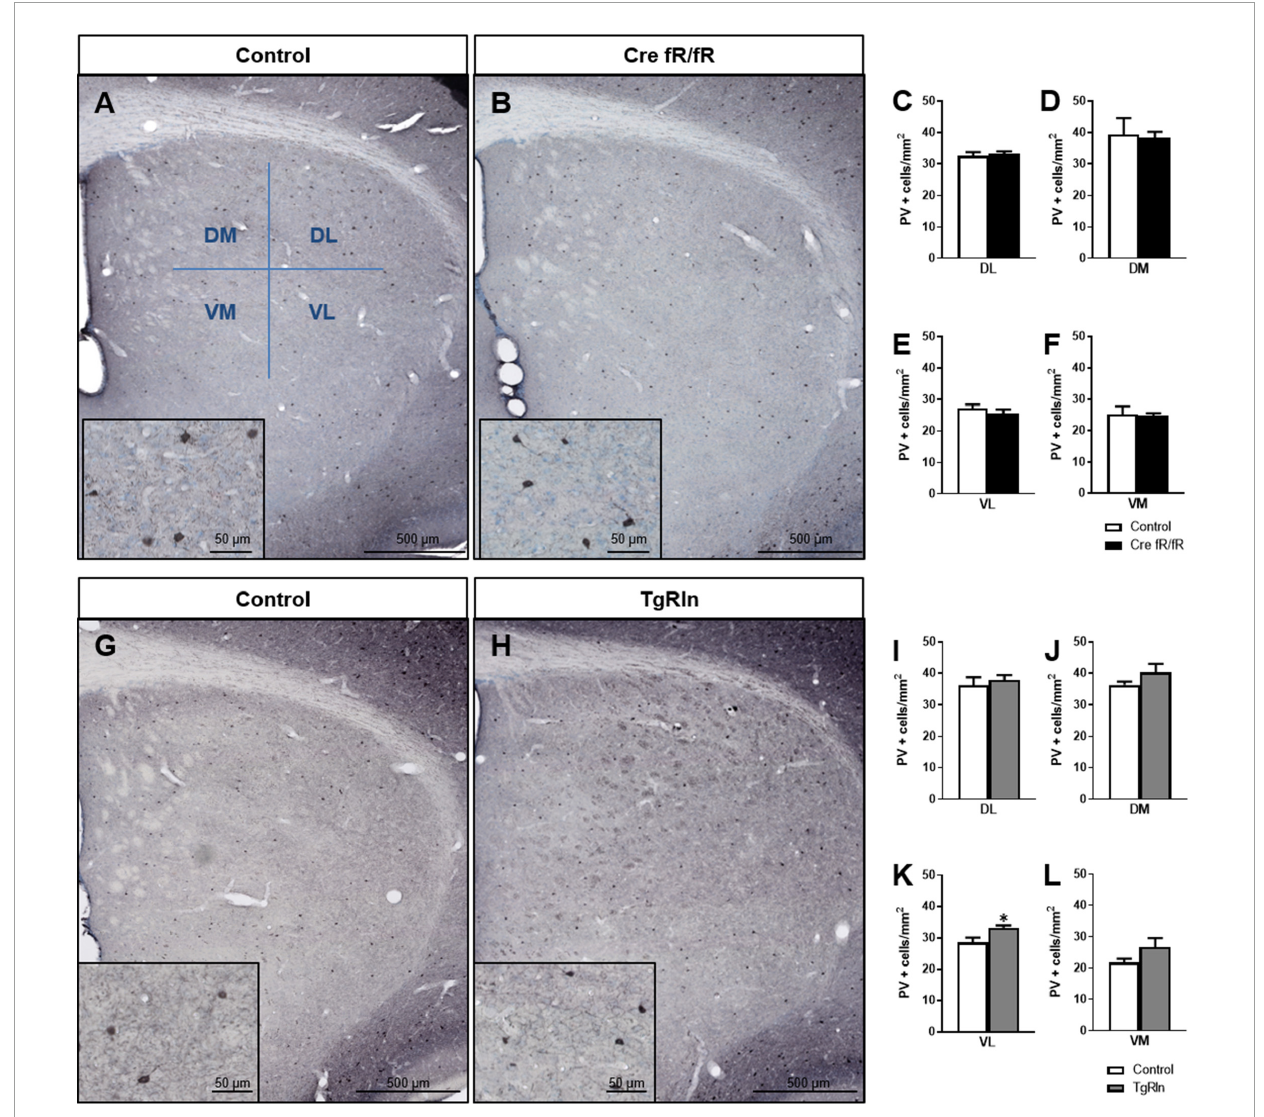
FIGURE4 Increased levels of Reelin alter the density of parvalbumin interneurons in the ventral-medial striatum. (A,B) Immunohistochemistry for PV in coronal sections of control and Cre fR/fR striatum, subdividing the striatum in four regions (as in Figure 3 ). (C–F) Quantification of the density of PV+ interneurons indicated no differences between the control and Cre fR/fR mice ( n = 4). (G,H) Representative images of PV immunostaining in the striatum of control and TgRln mice. Quantification of PV immunohistochemistry indicated an increase in the density of PV positive cells in the VL striatum of TgRln mice ( n = 4–5) (K) with no differences in the other striatal regions (I,J,L) . Scale bar: (A,B,G,H) , 500 µ m; high magnification insets 50 µ m. Statistical analyses were performed using Student’s t -test; * p < 0.05. Data are represented as means ±